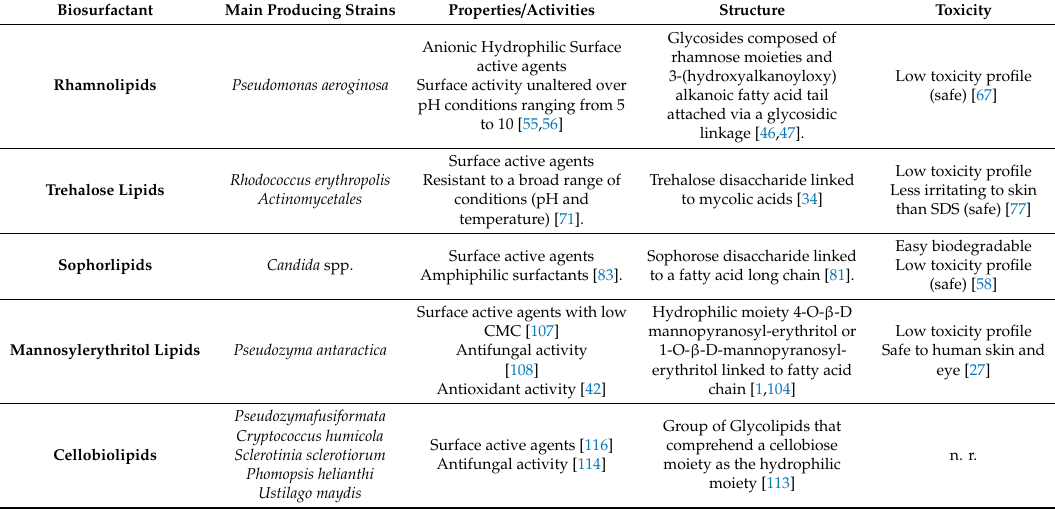
Table 1. Biosurfactants with glycolipid structure (low molecular